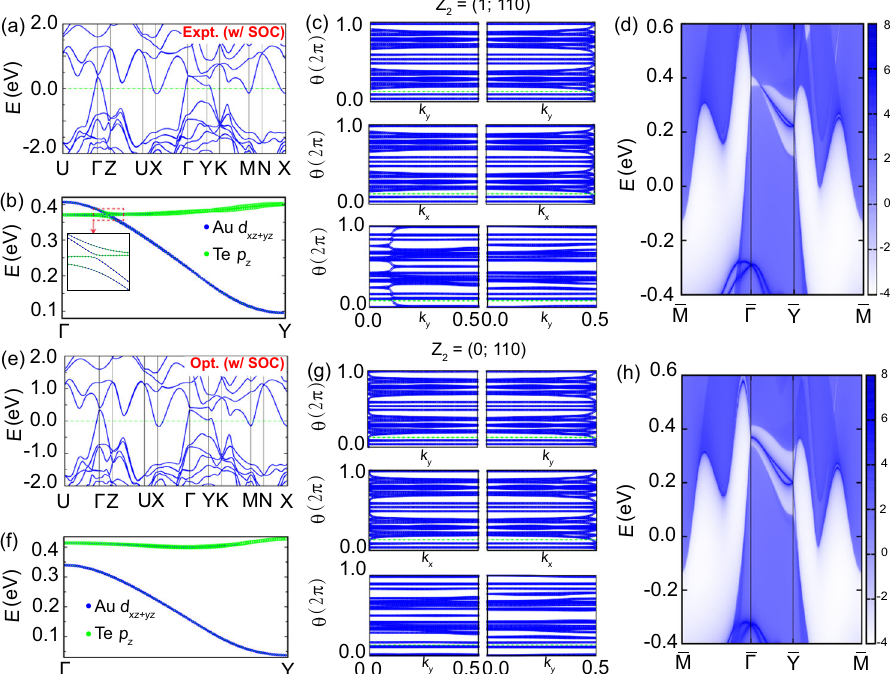
Fig. 2 Band structure calculations for AuTe 2 Br with SOC included. a – d are the calculated band structure, orbital-projected band structures along the Γ -Y direction, the evolution of the Wannier charge centers [ θ (2 π )], and the calculated surface states on the (001) projected surface for AuTe 2 Br with Expt. structural parameters, respectively. e – h are those results with Opt. structural